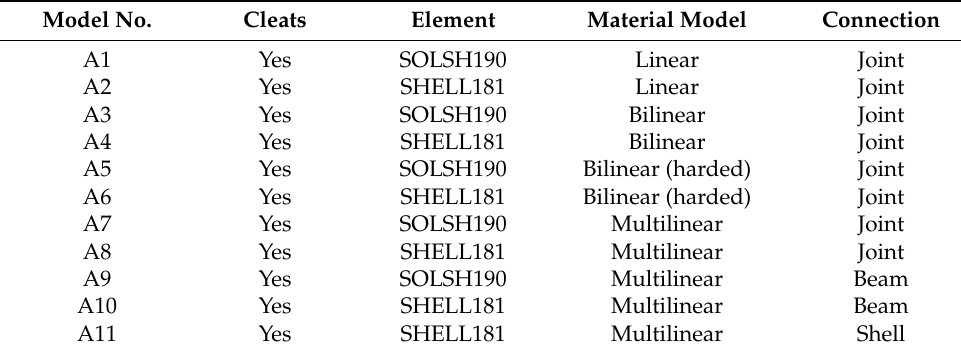
Table 1. Parameters of numerical models with cleats.